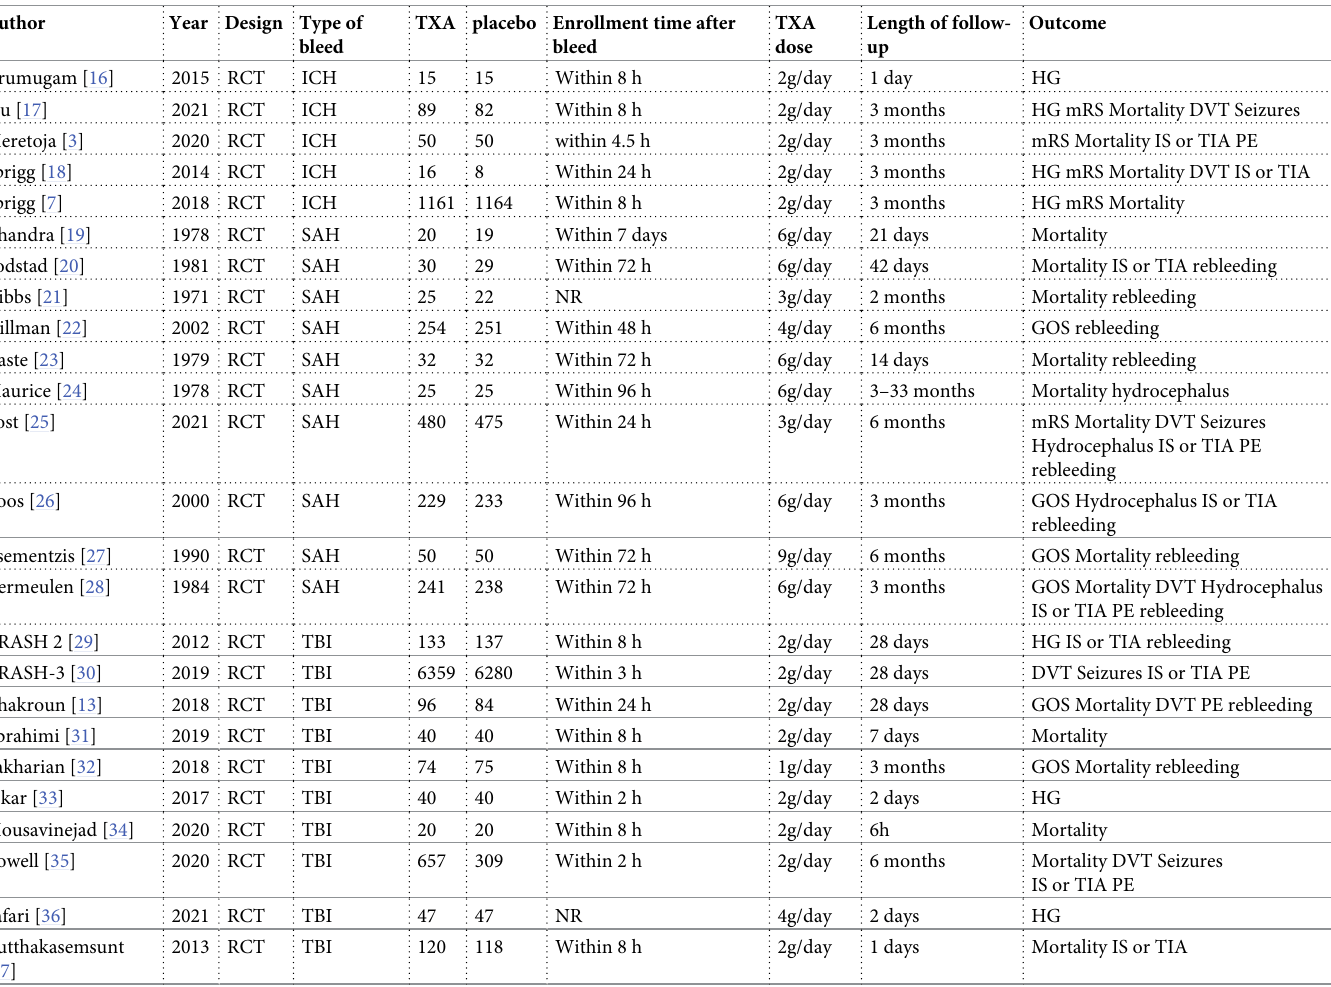
Table 1. The characteristics of the 29 included